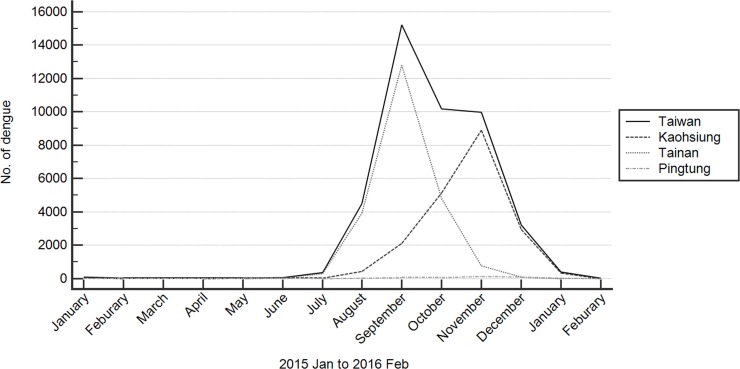
Monthly dengue fever cases in three southeastern cities in 2015.Monthly confirmed dengue case numbers are shown in three southeastern cities that were the three cities with the highest number of dengue cases in Taiwan’s history. We surveyed the presence of the DENV in the blood collected in the blood centers of Kaohsiung City and Tainan City.